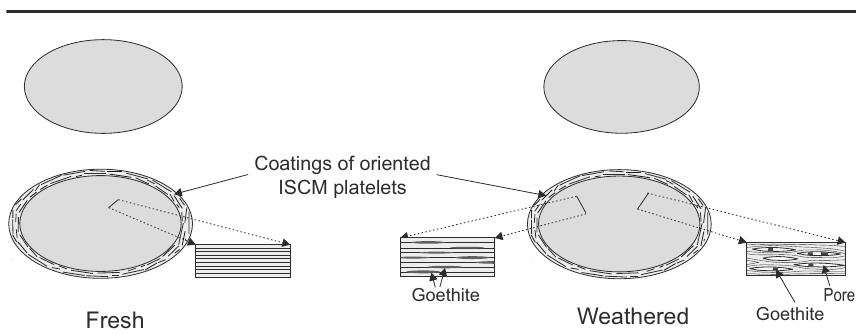
Figure 16. Type-III structural models for plates of micas (muscovite and biotite) and chlorite, which are either fresh or weathered. Weathered biotite and chlorite contain goethite crystals and lenticular